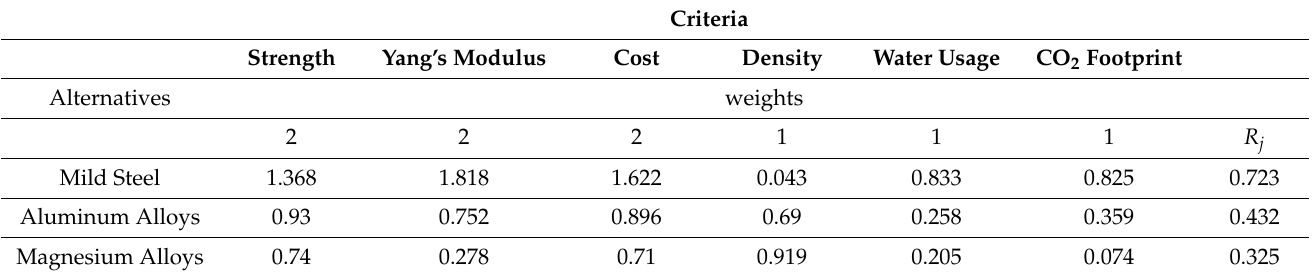
Table 5. Ranking decision score if the strength, Yang’s modulus, and cost are prioritized twice as much as the others.